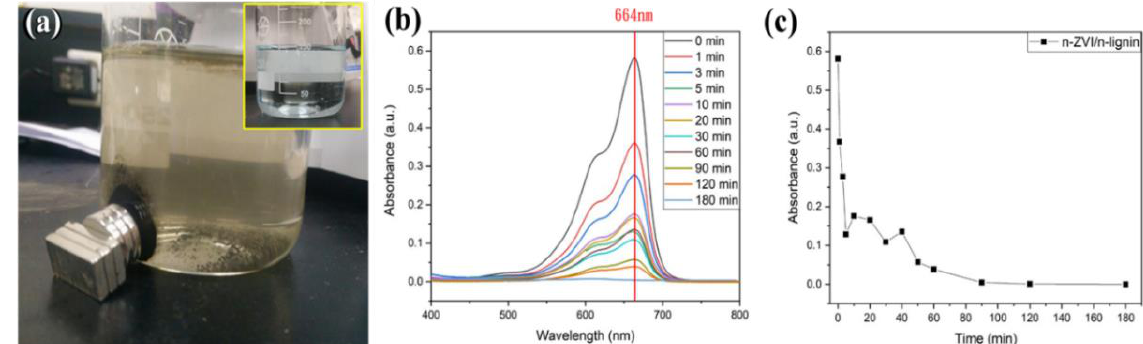
Figure 8. ( a ) The image of the degradation of methylene blue in aqueous solutions by nZVI/n-lignin. The inset is the image before the addition of nZVI/n-lignin. ( b ) UV – Vis spectra of high ratio test and ( c ) the absorption as a function of time at the wavelength of 664 nm.